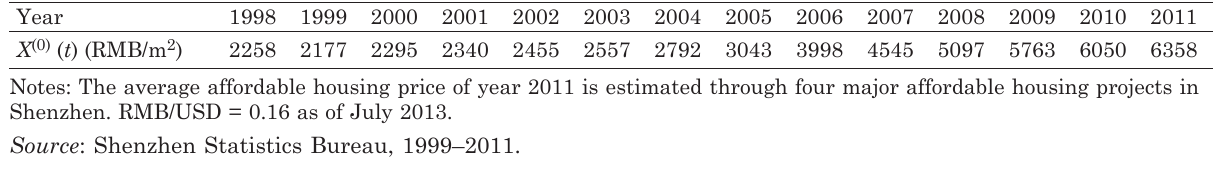
Table 1. Historical time series on the affordable housing